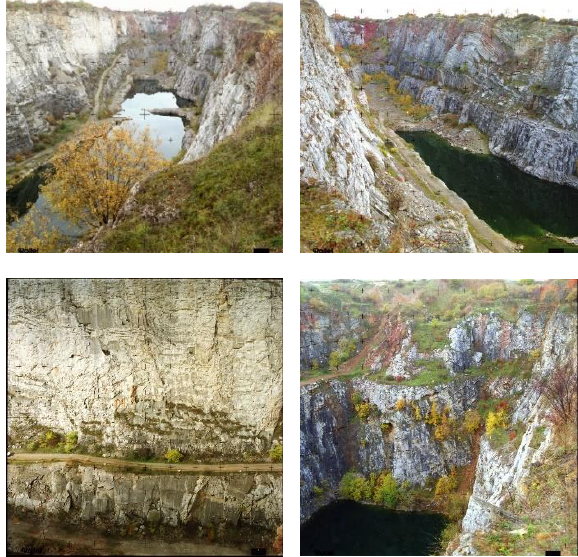
Figure 1. Limestone quarry the Great America on Rollei 6006 metric